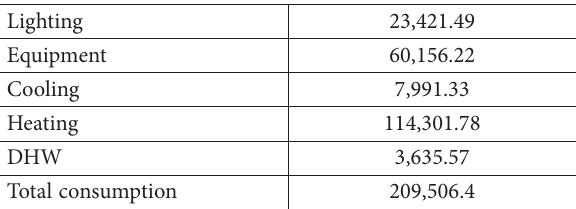
Table 8. Final energy consumption of the building with